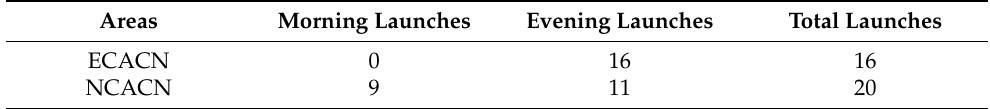
Table 1. Radiosonde data collection of two areas.